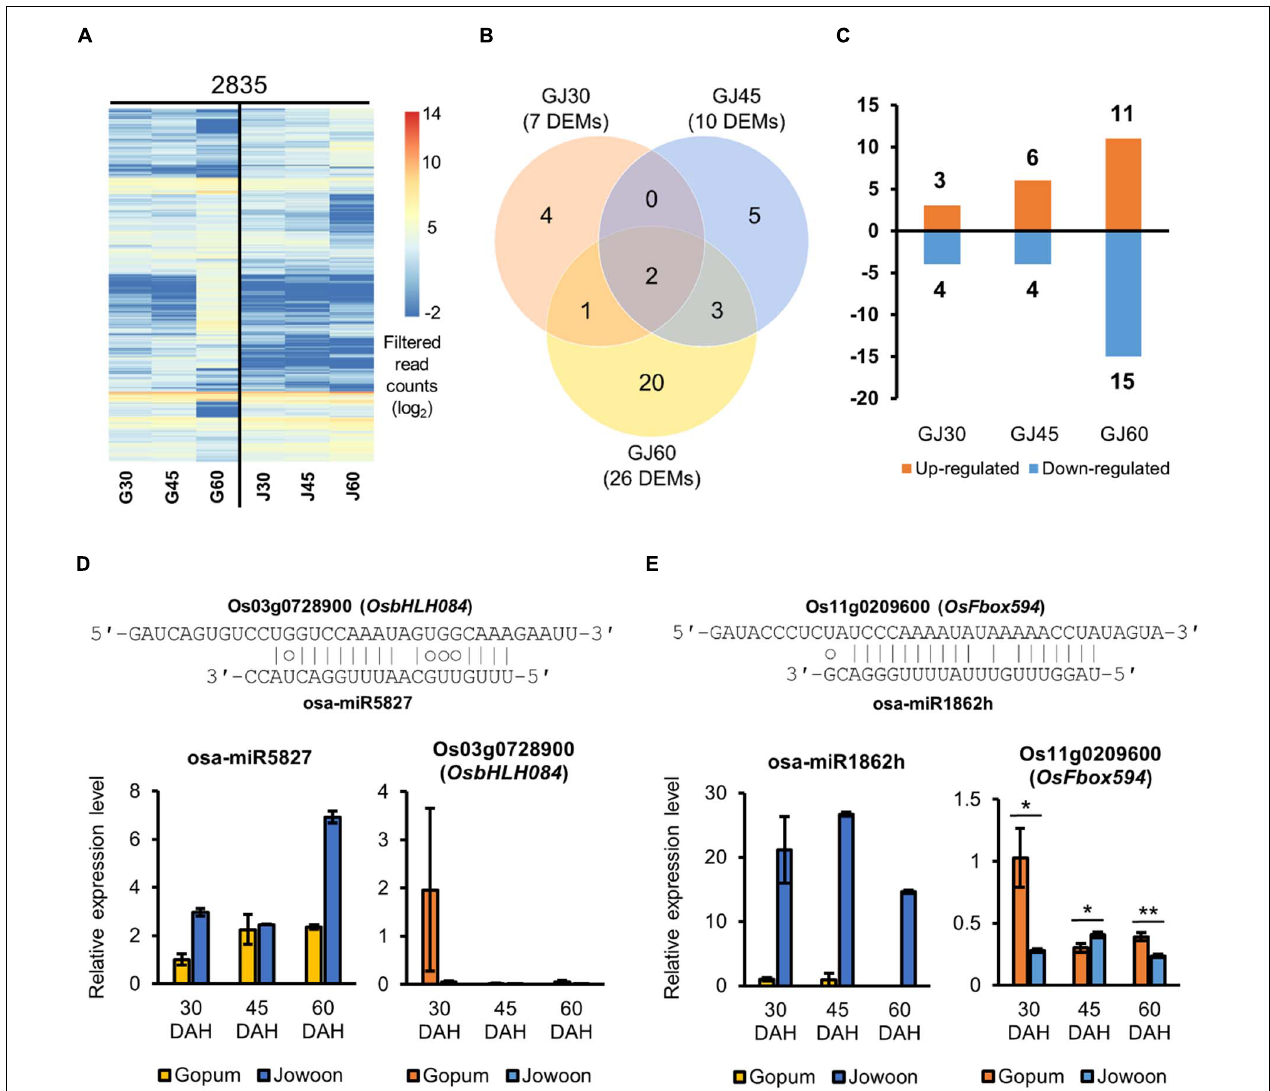
FIGURE 6 | Identification and expression analysis of differentially expressed miRNAs (DEMs) and the corresponding target genes. (A) Heat map of the expressed miRNAs in the embryo of Gopum and Jowoon. Expressed miRNAs, aligned to miRBase and PmiREN, were shown as filtered read counts (log 2 ) values. (B) Comparison of Gopum and Jowoon based on the number of DEMs in the embryo of GJ30, GJ45, and GJ60. (C) Number of miRNAs up- or down-regulated in Jowoon compared with those in Gopum in the embryo of GJ30, GJ45, and GJ60. (D,E) Relative expression levels of miRNAs and corresponding target genes, which were predicted to affect PHS. The pairing between miRNAs and their target genes is indicated. The relative expression levels of genes were validated by qRT-PCR. Data represent mean ± SEM ( N = 3). Significance is determined by Student’s t- test, * P < 0.05 and ** P < 0.01.